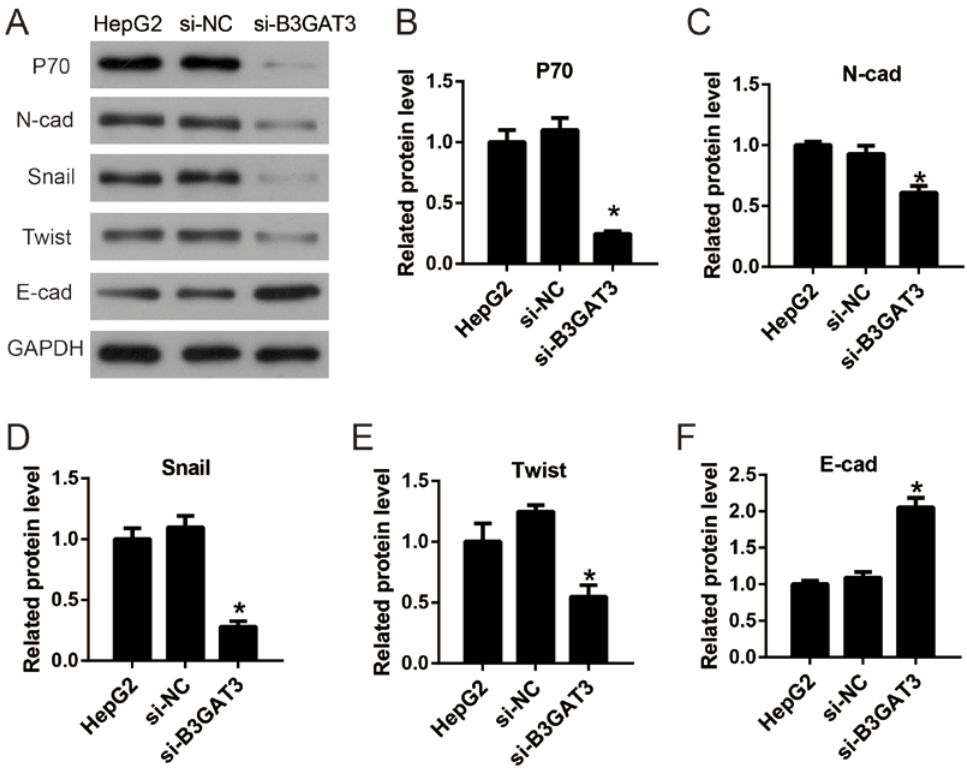
Figure 5: Knockdown of B3GAT3 reversed the EMT process of liver cancer cells. (A) The expression levels of P70 and EMT related genes were detected by western blot. (B-F) The values of the band intensity represent the densitometry estimation of each band normalized to GAPDH. *P<0.05 compared with